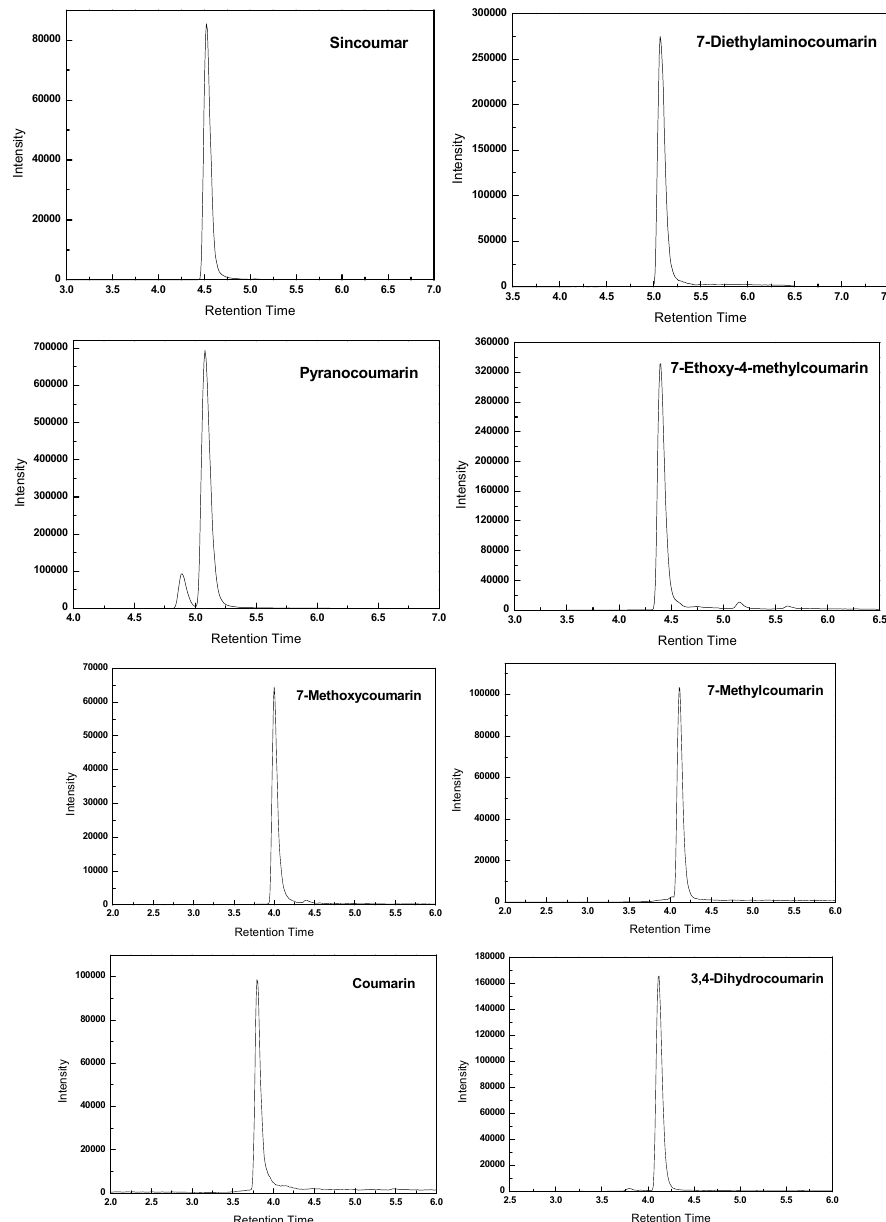
Figure 4. The chromatograms of coumarin and its derivatives spiked at 50 μ g·kg − 1 .